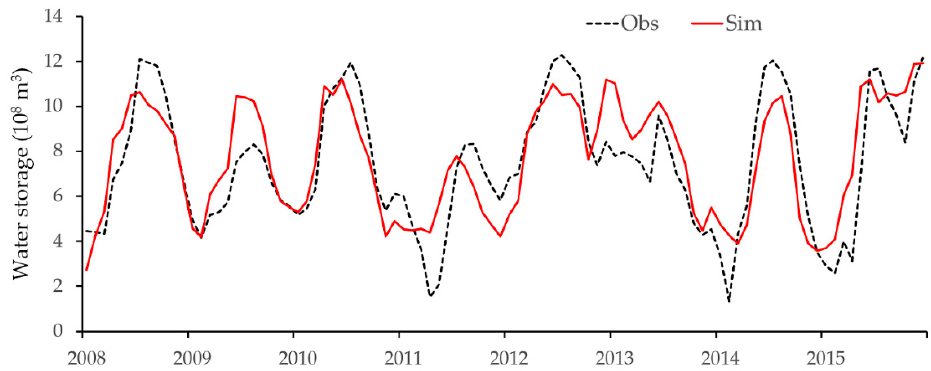
Figure 4. Monthly simulated and observed water storage of Tuanjie Reservoir during 2008–2015.